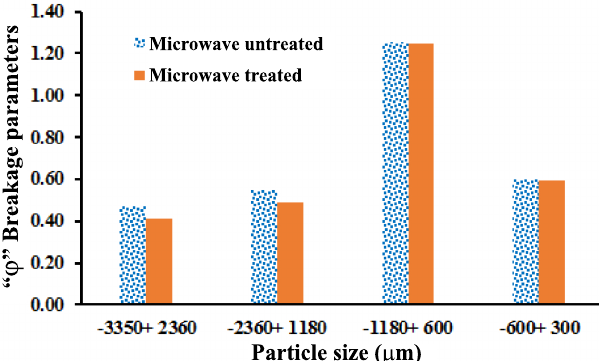
Fig. 9. " j " Breakage distribution parameter for different fractions for treated and untreated